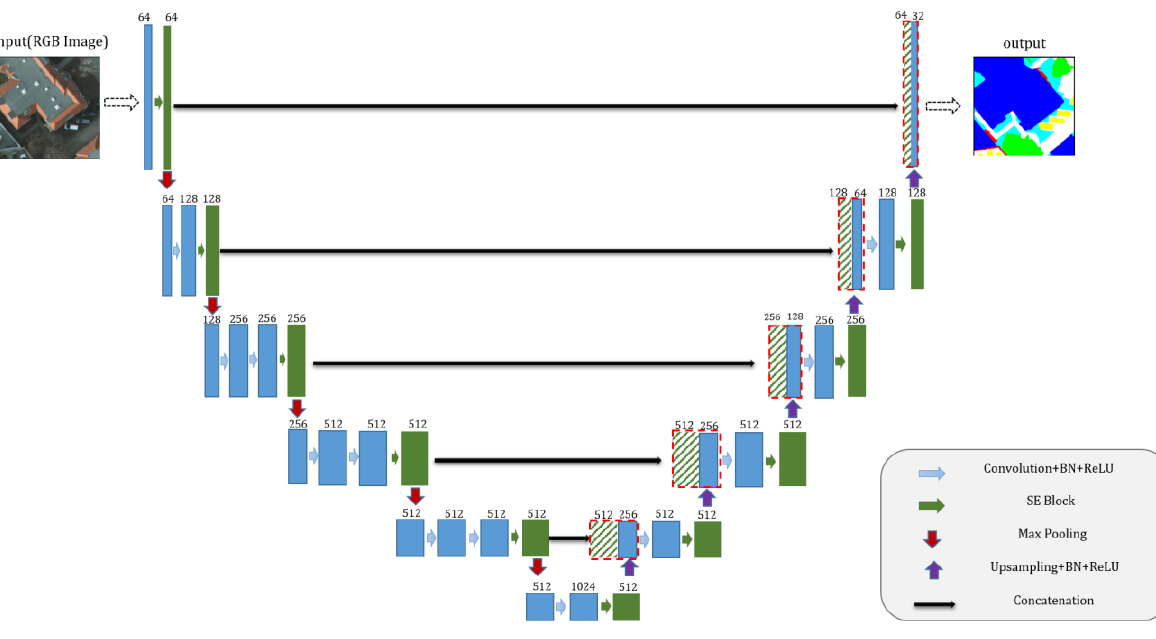
Figure1. Diagram of overall architecture of attention